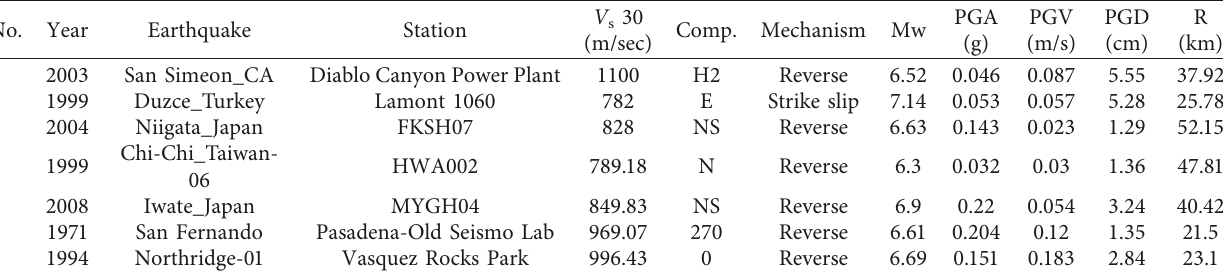
Figure 7: Forward, backward, and neutral directivity zones in a region near to an active fault [47]. Table 5: Far-fault ground motion records.